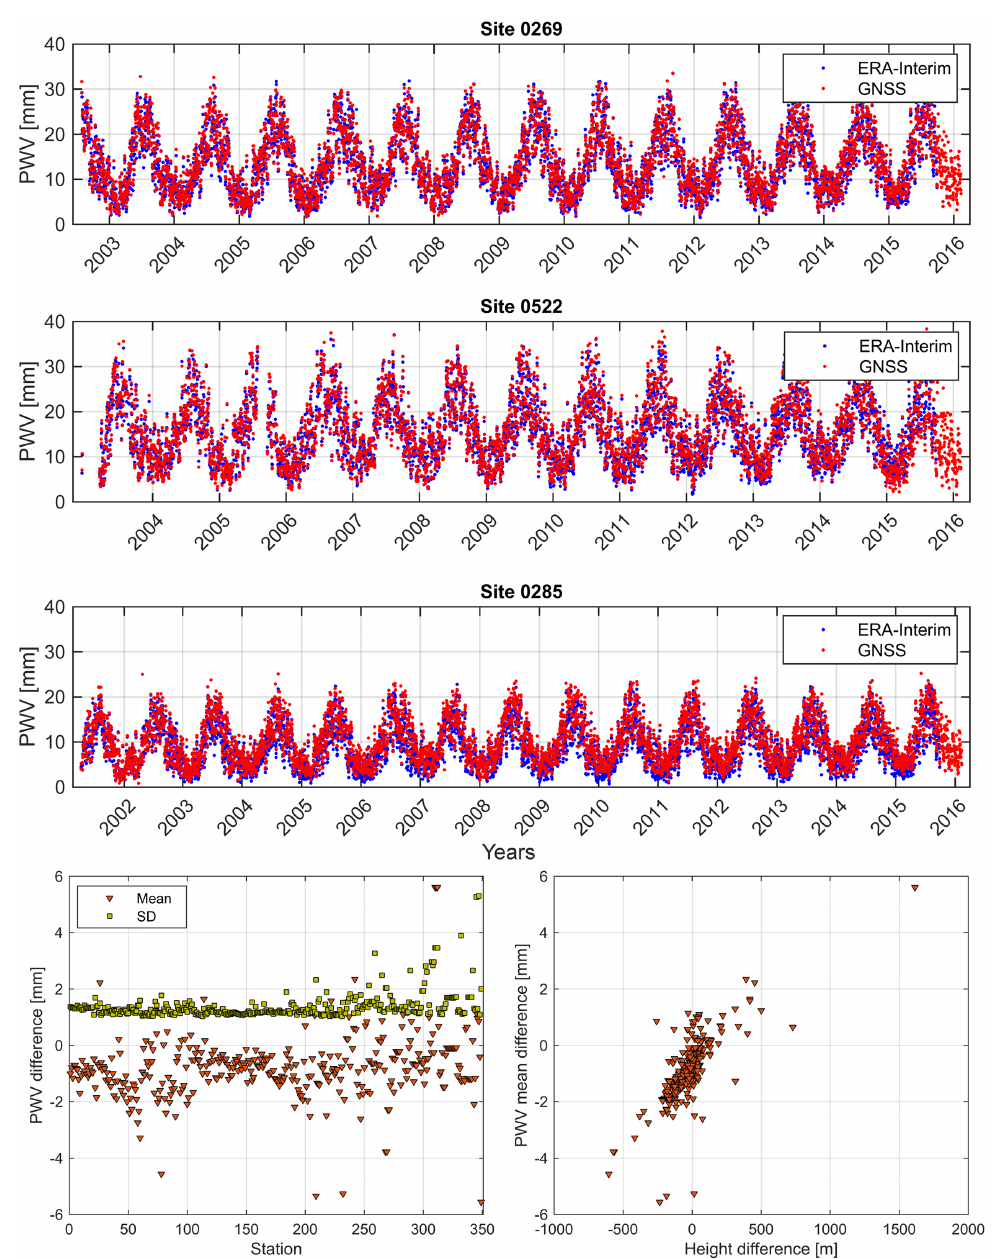
Figure 2. PWV estimated at three GNSS sites (site 0269 in Wertach, Germany, at altitude of 907ma.m.s.l.; site 0522 in Pirmasens, Germany, at altitude of 399ma.m.s.l.; and site 0285 in Garmisch, Germany, at altitude of 1779ma.m.s.l.) and the corresponding PWV from ERA- Interim. The bottom sub-figures show (left) the mean of PWV difference (ERA-Interim–GNSS) and (right) the standard deviation at all